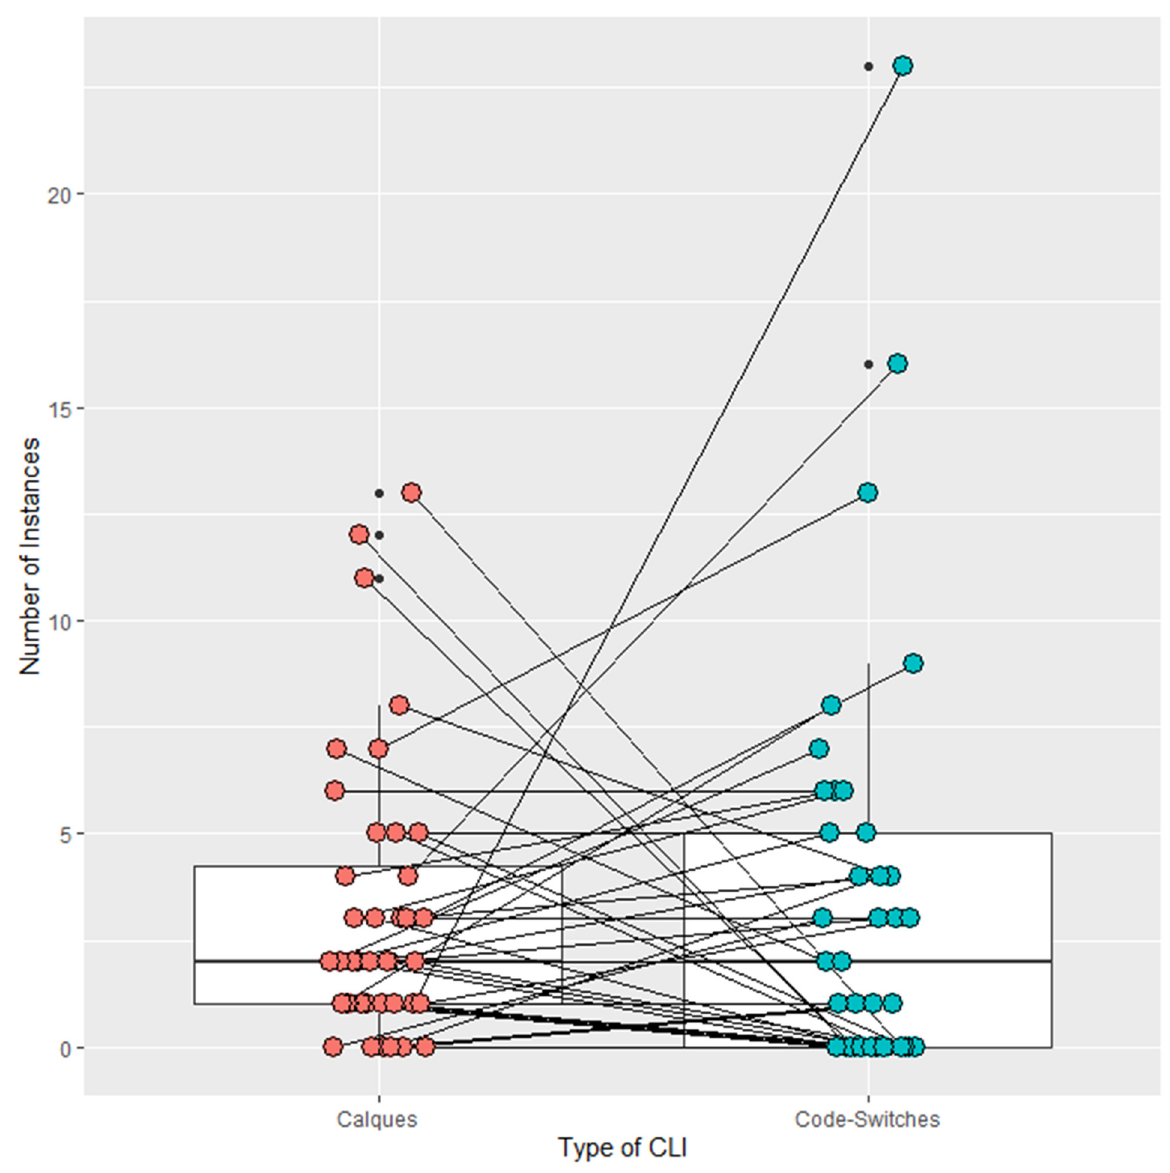
Figure 4. Calque and Code-switching Instances .